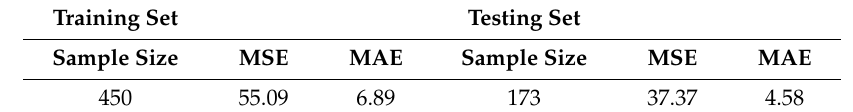
Table 5. Training result of the convolutional neural network (CNN).